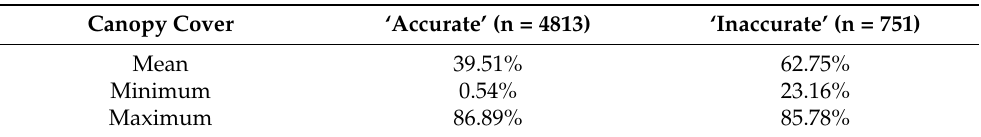
Figure 5. Canopy cover around the measured positions. Table 3. The impact of canopy cover, estimated from the canopy height model for ‘Accurate’ and ‘Inaccurate’ harvester positions.